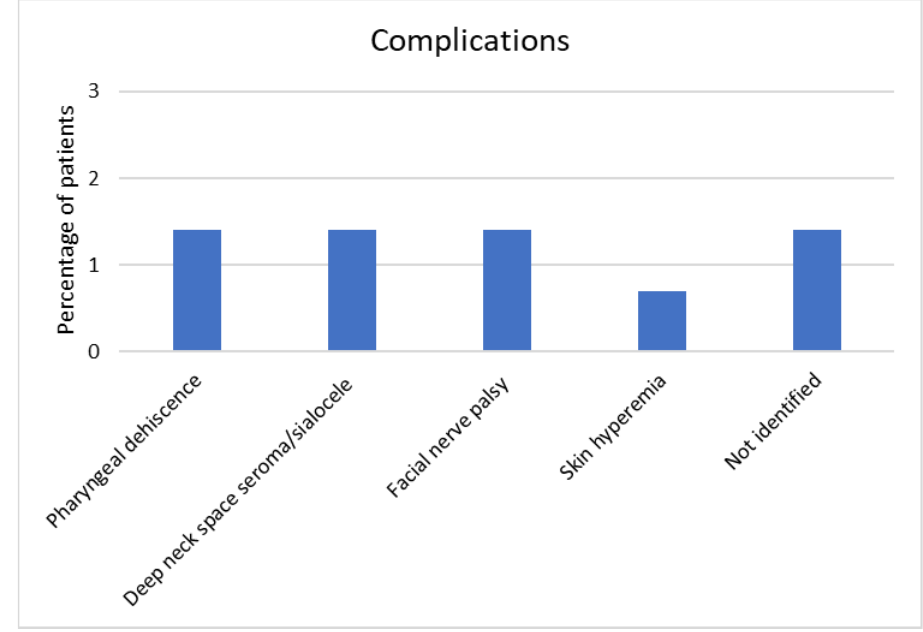
Figure 4. Complications in transoral approach.